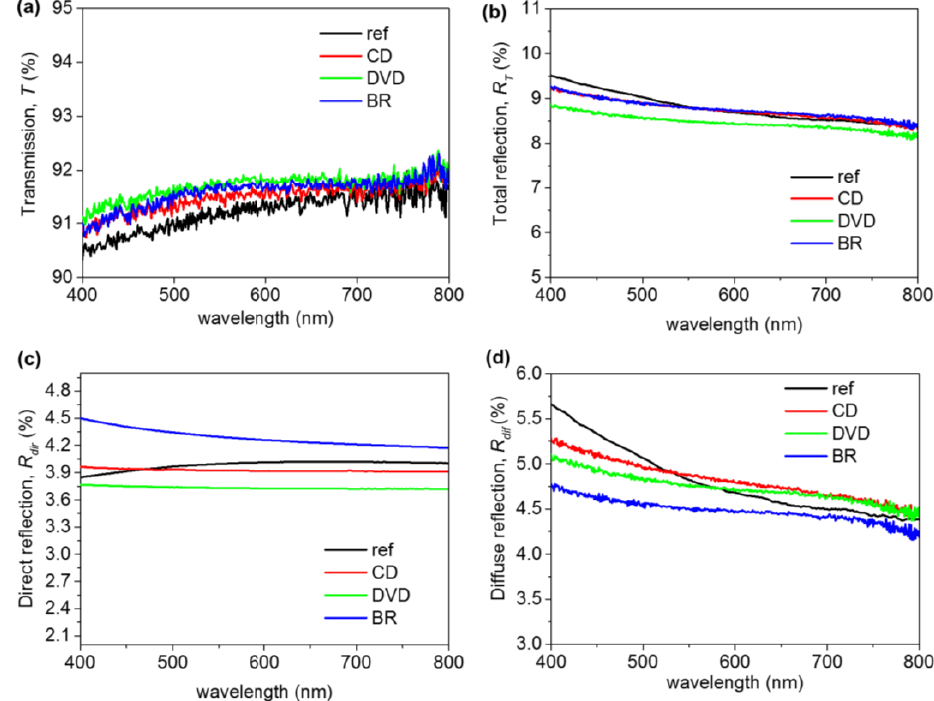
Figure 3. Optical measurements of ordered 1D nanostructures. ( a ) Transmission spectra ( T ). ( b ) Total reflection spectra ( R T ). ( c ) Direct reflection ( R dir ). ( d ) Diffuse reflection ( R dif ).